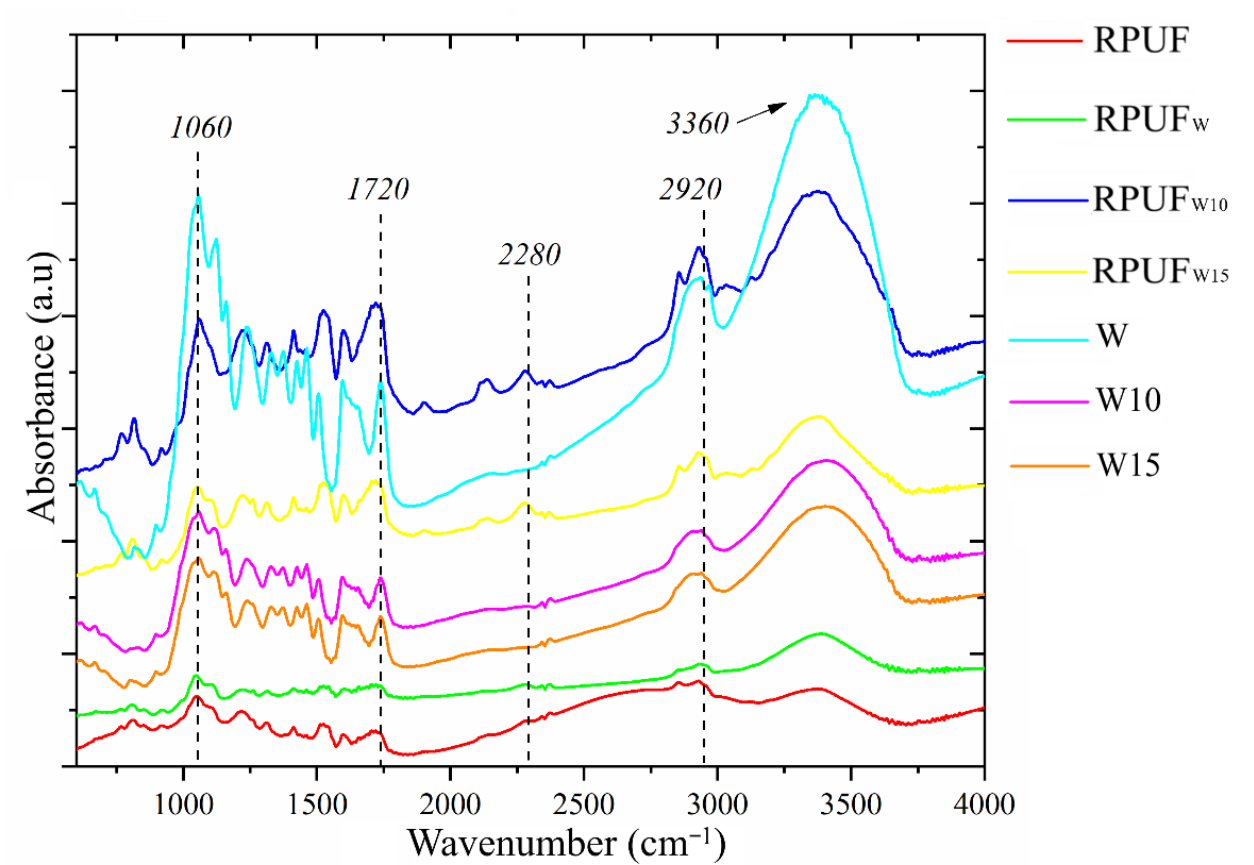
Figure 3. FTIR spectra of the studied fillers and RPUFs.